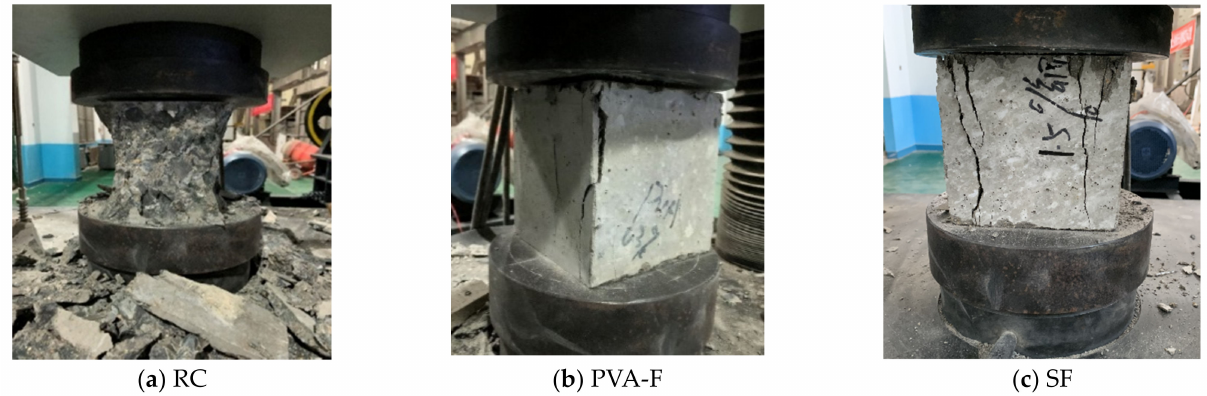
Figure 8. Failure patterns of test cube concrete.